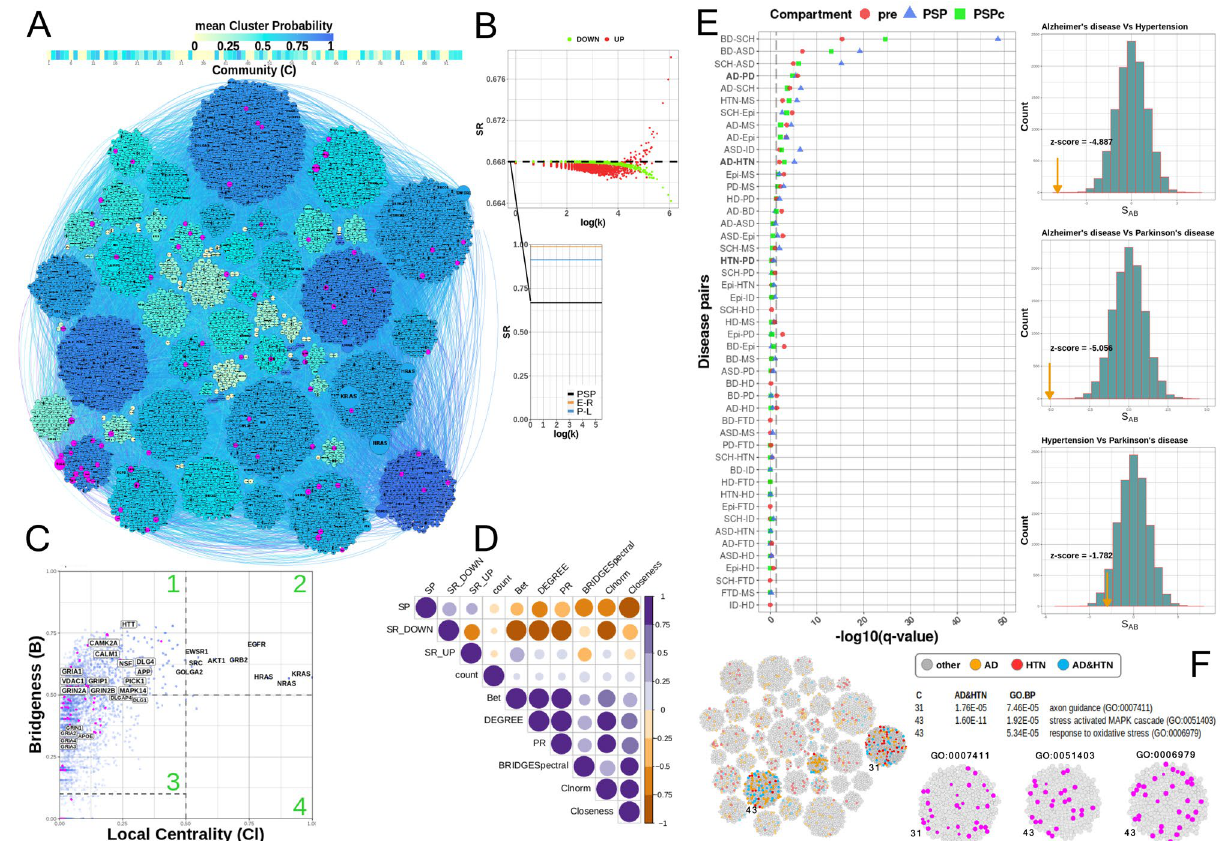
Figure 3. ( A ) Community structure of the PSP network using the Spectral modularity method. Communities are coloured using the average gene-community probability values: bluer coloured a community is, the more probable the genes are of belonging to that community on average. Nodes coloured magenta highlight the core PSD95 interactors 25 , which is also highlighted magenta in the Bridgeness plot in ( C ). ( B ) Graph entropy plots: (main) Global graph entropy rate (SR) plot comparing the structure of the PSP network (0.668) against 1000 randomised Erdos–Renyi (E–R = 0.989 + − 0.0005) and Power–Law (P–L = 0.9127 + − 0.0032, α PSP = 2.41) models of similar size, (Enlarged) Evidence for scale-free structure in PSP network using a perturbation analysis (10], plotted is the SR values after each protein is perturbed through over-expression (SR_UP = red) and under- expression (SR_OWN = green), against the log of the proteins degree,. ( C ) Bridging proteins, estimated using the Spectral clustering algorithm are plotted against semi-local centrality (Methods), allowing their categorisation: Region 1, proteins having a ’global’ rather than ’local’ influence in the network (also been called bottle-neck bridges, connector or kinless hubs 12 (DLG4, GRIN2B, CAMK2A, etc.). Region 2, proteins having ’global’ and ’local’ influence (EGFR, HRAS, NRAS, etc.). Region 3, proteins centred within the community they belong to, but also communicating with a few other specific communities (GRIN1, GRIA2-4). Region 4, proteins with ’local’ impact , primarily within one or two communities (local or party hubs 9 . ( D ) Correlation plot for different centrality measures estimated for PSP network.: SP - a protein’s shortest path value, SR_UP-Entropy rate when protein is over expressed, SR_DOWN—entropy rate when protein is under expressed, COUNT - number of protein identifications in the studies, Bet - protein’s betweenness centrality value, Degree—protein degree, PR- Page Rank, BRIDGESpectral —protein Bridgeness value, CNorm - Protein’s local centrality value, Closeness - protein’s closeness value; correlation between SR_UP and Bridgeness indicates that genes with higher Bridgeness values also lower the graphs entropy when active/overexpressed, which allows the signal to pass more freely (Supplementary Table 2). ( E ) left: Disease-disease relationship for presynaptic (red) and PSD full (blue) and PSD consensus (green) interactome. Where significance q-values < 0.05 is delineated by the dashed line. Schizophrenia (SCH), Autistic Spectrum Disorder (ASD), Autistic Disorder (AUT), Bipolar Disorder (BD), Intellectual Disability (ID), Alzheimer disease (AD), Epilepsy Syndrome (Epi), Parkinson’s Disease (PD), Frontotemporal Dementia (FTD), Huntington’s Disease (HD) and Multiple Sclerosis (MS) are considered; right : randomisation studies for disease-disease pairs overlap, yellow arrow shows the measured value of Z-score compared to 10,000 AD-HTN, PD-HTN and AD-PD random models. ( F ) Colocalization of AD and HTN on the PSP network by propagating these gene-disease associations (GDA) through the network using the Belief Propagation DC-SBM algorithm 13 . The colocalization of AD and HTN shared common molecular pathways in communities 31 and 43, which were also found enriched for axon guidance, stress-activated MAPK cascade and response to oxidative stress GO BP